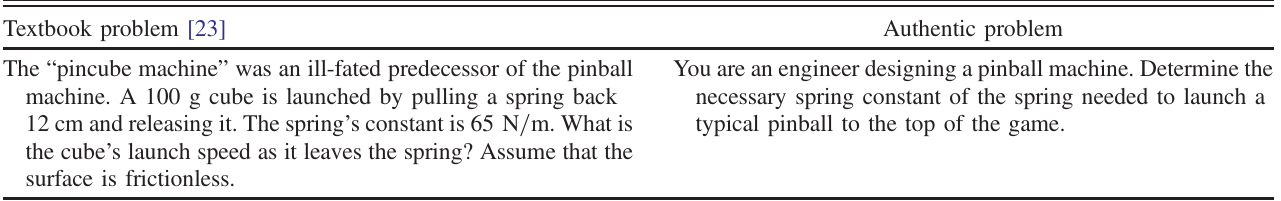
You are an engineer designing a pinball machine. Determine